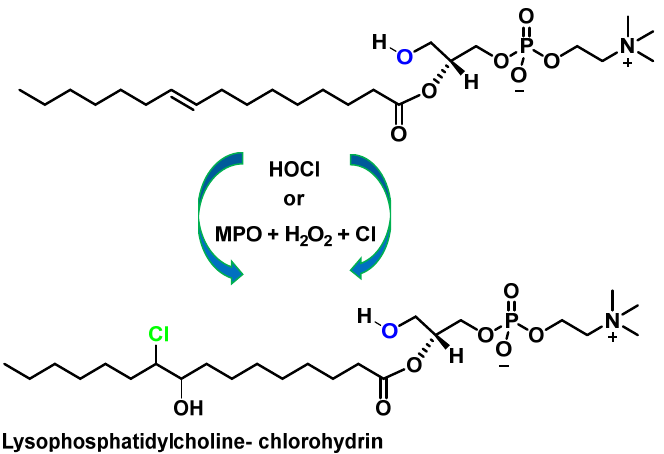
Figure 11. The alkene bond in the unsaturated molecular species of lysophosphatidylcholine is targeted by HOCl to yield a chlorohydrin molecular species. The second most abundant phospholipid in LDL after phosphatidylcholine (~900 μ g per mg of protein) is sphingomyelin [50] (~400 μ g per mg protein). Sphingomyelin is the only human phospholipid that does not contain glycerol but has the amino alcohol sphin- gosine. The fatty acid of sphingomyelin is bound to sphingosine by the amino group, while the polar group of phosphocholine is bound to the hydroxyl group of sphingosine. The HOCl targets on the sphingomyelin molecule are the sphingosine double bonds and the hydrogen atom of the amide. The rate constant of the reaction of HOCl with sphingo- myelin was estimated to be 18.7 ± 3.05 M − 1 s − 1 [51], which is faster than the reaction be- tween HOCl and unsaturated acyl chain bonds (0.56 M − 1 -s − 1 ) [52], as shown in Figure 12. Figure 12. Sphingomyelin modification by HOCl or H 2 O 2 /MPO/Cl − . Chlorinated sphingomyelin de- rivatives produce significant deleterious effects on cells, including apoptosis and DNA damage.